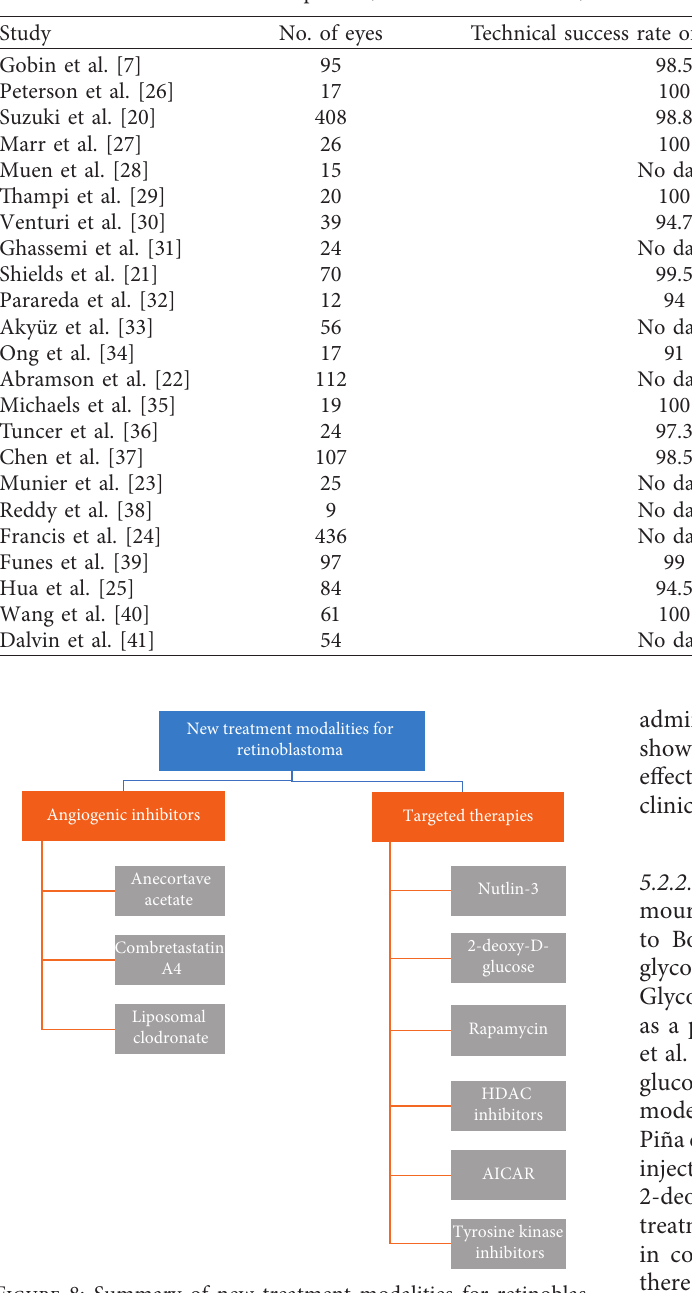
Table 7: Sample size, technical success rate, and duration of follow-up across analysed